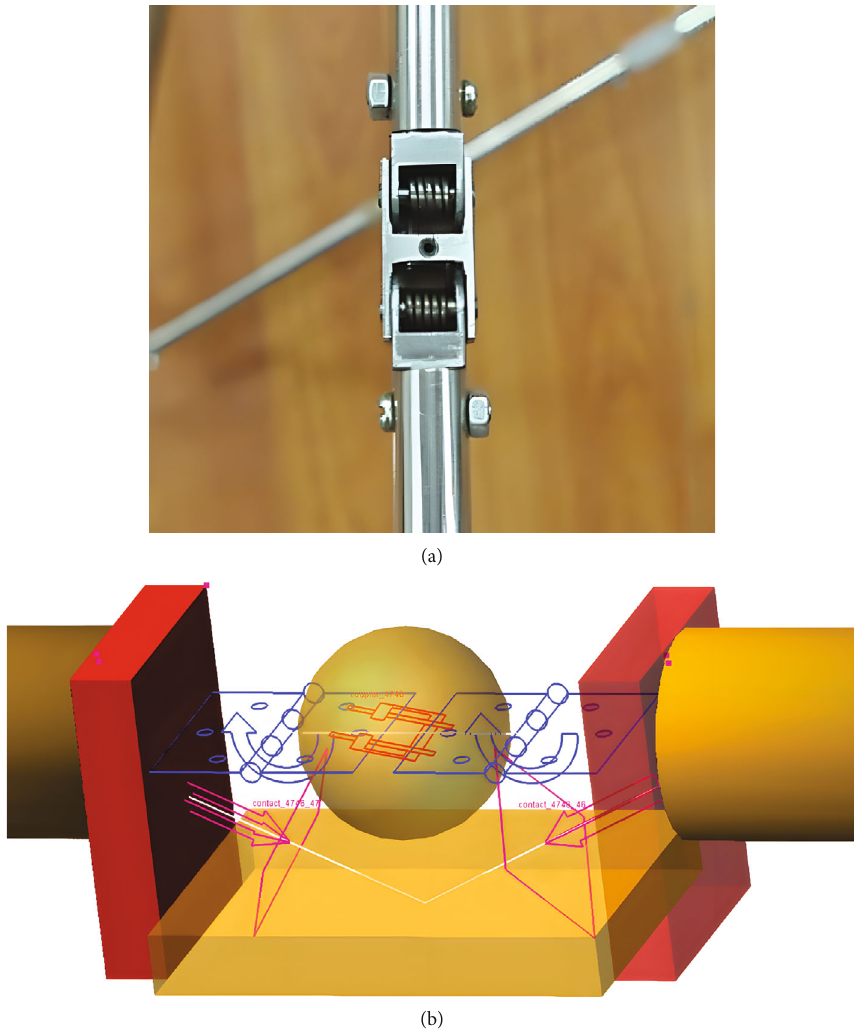
Figure 5: Synchronous hinge products and models. (a) Synchronous hinge products. (b) Synchronous hinge models.